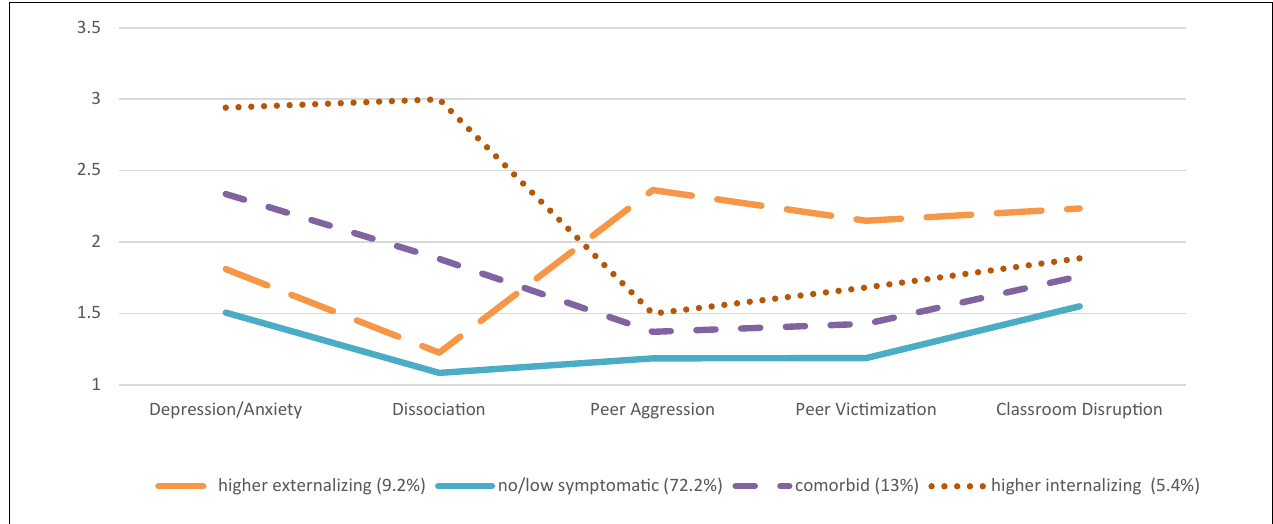
FIGURE 1 | The four profiles of internalizing and externalizing symptoms identified by latent profile analysis (NPPV).